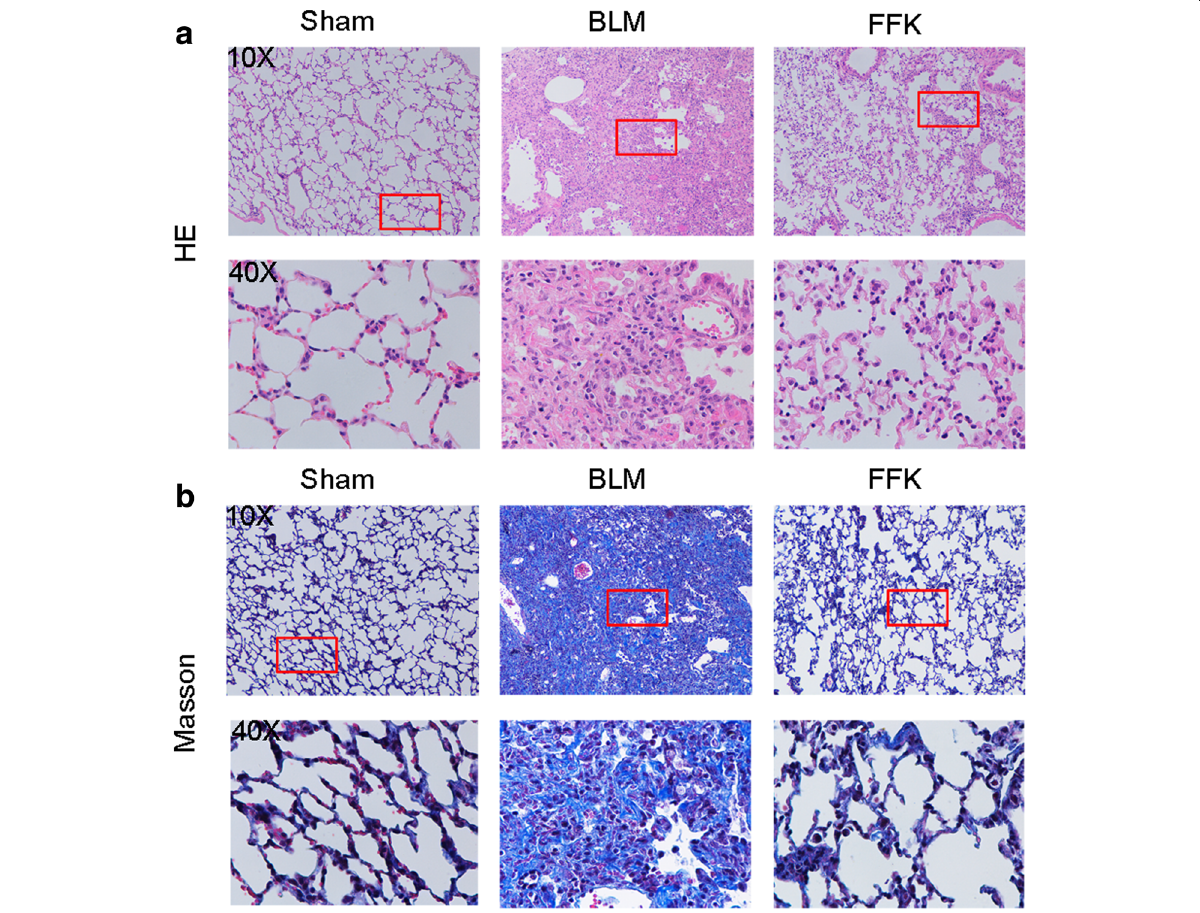
Fig. 1 Anti-pulmonary fibrosis of FFK in BLM-treated mice. a FFK improved the alveolar structure of mice compared with the BLM group as shown by H&E staining of animal models. b FFK inhibited the collagen fibers as shown in Masson ’ s staining. The color blue represents collagen